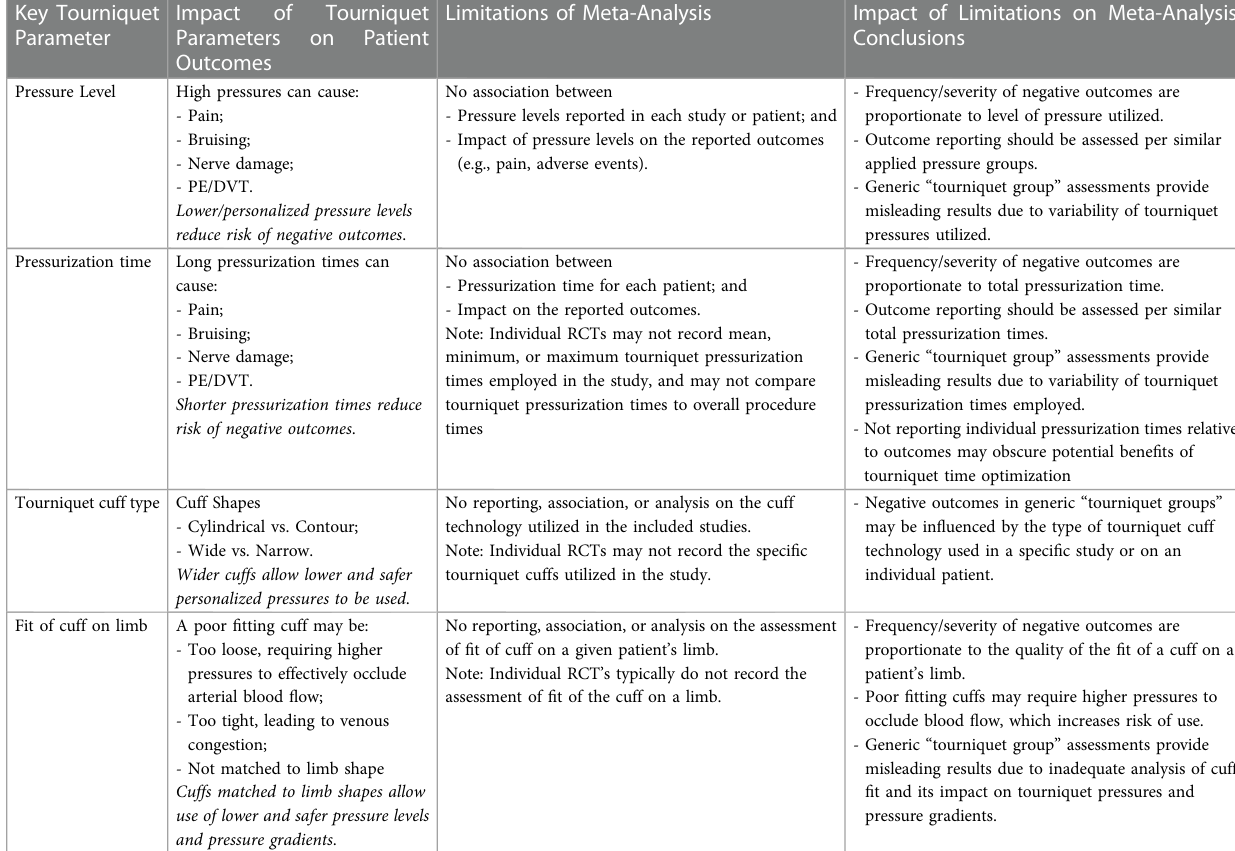
TABLE 2 Limitations of meta-analyses for identifying key tourniquet parameters and their